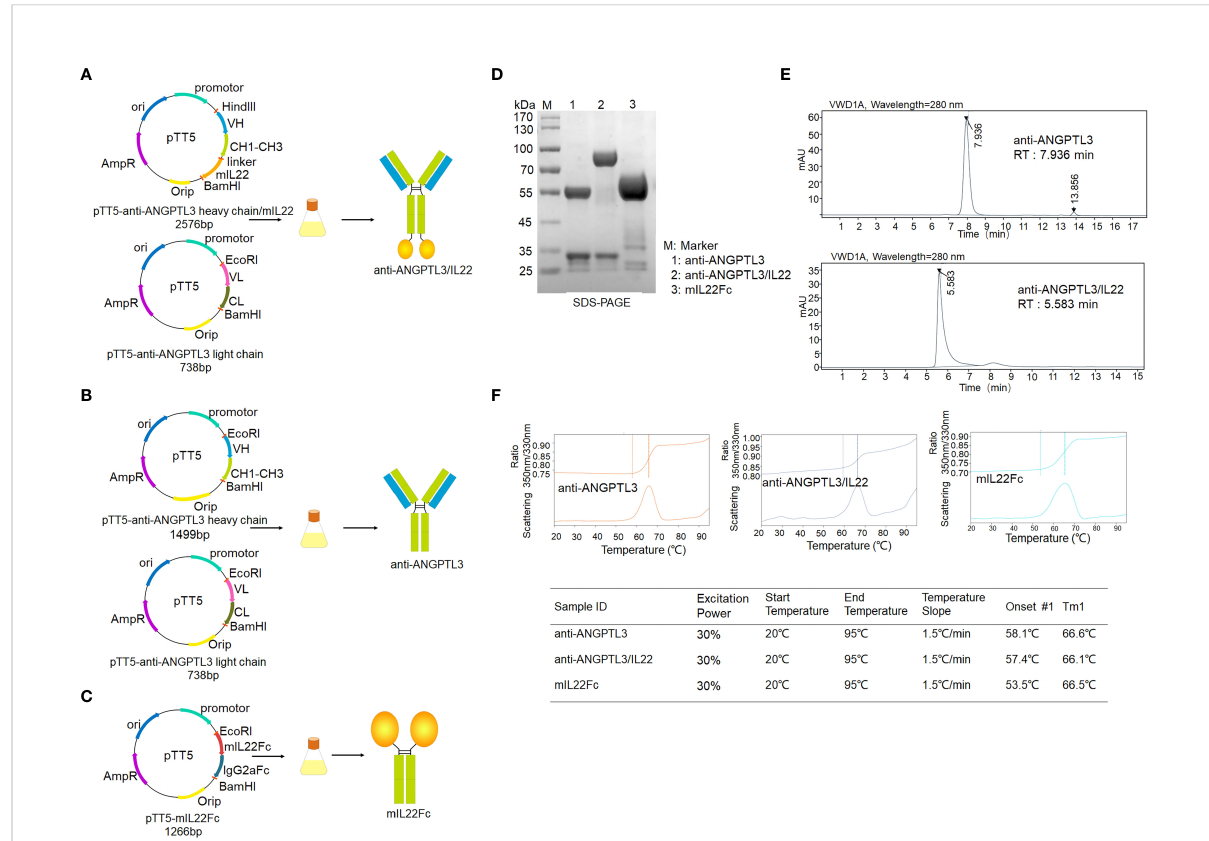
FIGURE 1 Expression and puri fi cation of anti-ANGPTL3/IL22 fusion protein. (A) Schematic representation of the preparation and puri fi cation of anti- ANGPTL3/IL22 fusion protein. Mouse IL22 was fused to the C-terminus of the anti-ANGPTL3 heavy chain via a fl exible linker (linker sequence: GGGGSGGGGSGGGGS). (B) Schematic representation of the preparation and puri fi cation of anti-ANGPTL3. (C) Schematic representation of the preparation and puri fi cation of mIL22Fc (Mouse IL22 and mouse IgG2a Fc fusion protein). (D) SDS-PAGE analysis of anti-ANGPTL3 (lane 1), anti- ANGPTL3/IL22 (lane 2) and mIL22Fc (lane 3) under reducing condition (anti-ANGPTL3: approximately 150 KD, IL22Fc: approximately 90 KD, anti-ANGPTL3/IL22: approximately 190 KD). (E) SEC-HPLC analysis of anti-ANGPTL3 and anti-ANGPTL3/IL22 fusion protein (RT, retention time). (F) Thermal stability analysis of anti-ANGPTL3, anti-ANGPTL3/IL22 and